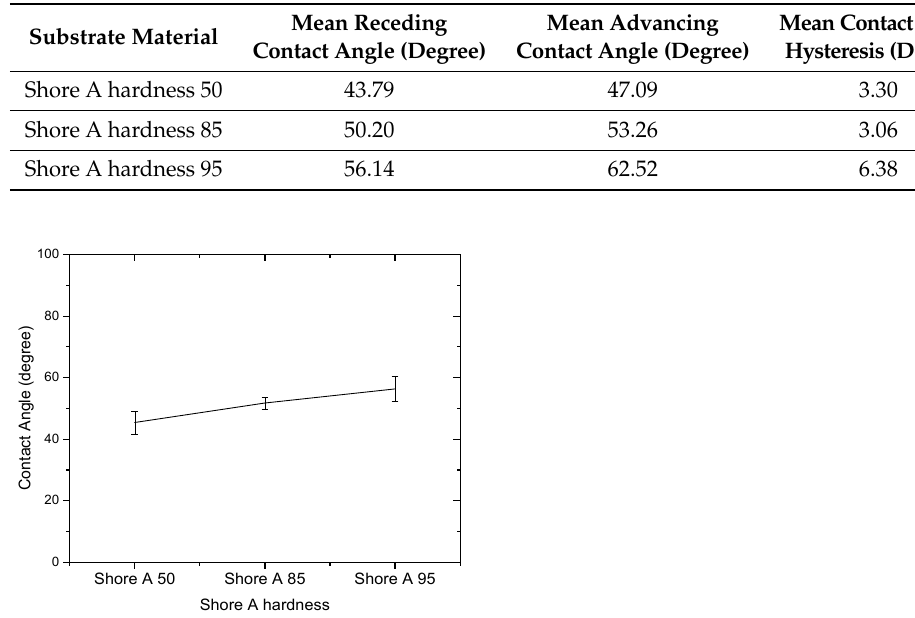
Figure 2. Contact angles of distilled water on substrates with different Shore A hardness